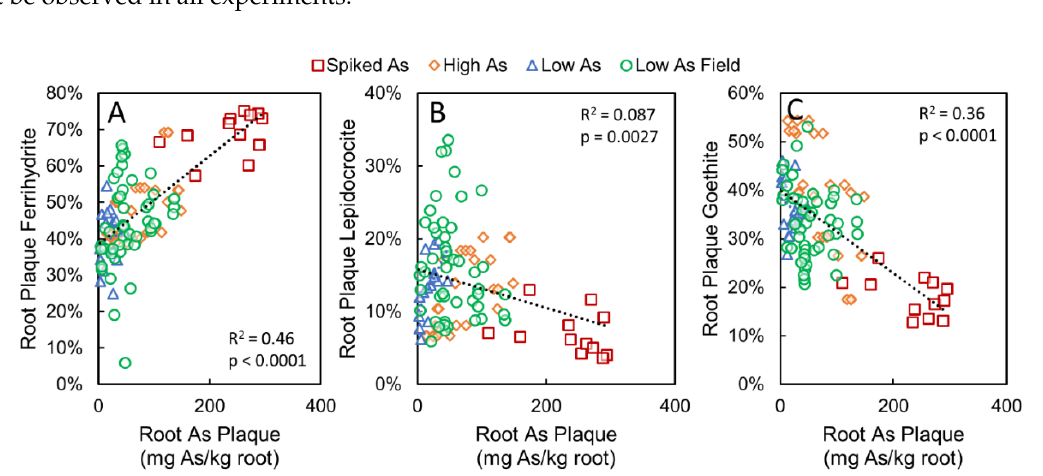
Figure 5. Relations between plaque As and the proportion of Fe plaque comprised of ( A ) ferrihydrite, ( B ) lepidocrocite, and ( C ) goethite across all tested experiments.